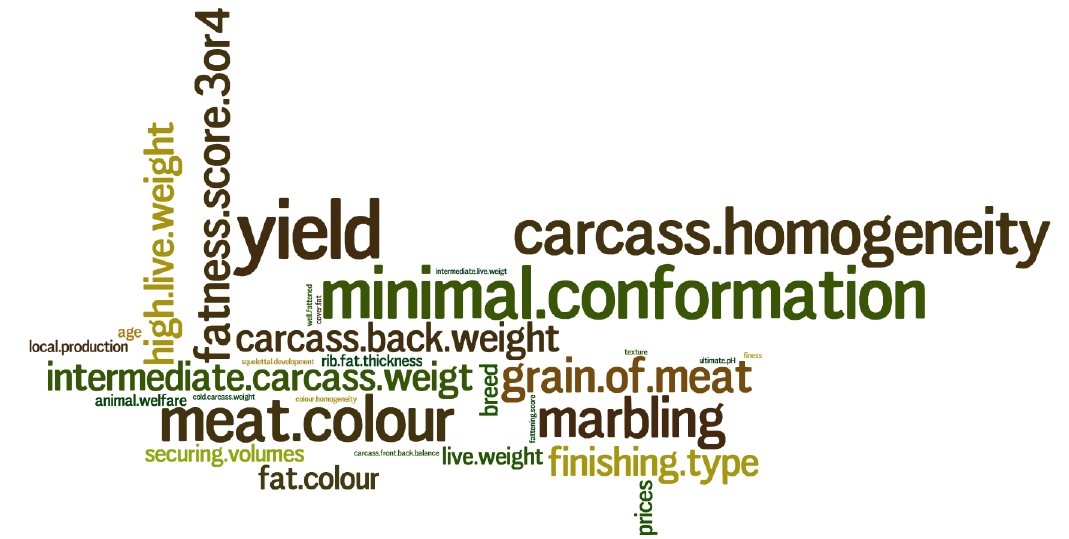
Figure 1. Main expectations expressed by the 13 operators in the sector surveyed. (The size of the expectations was proportional to its percentage of citation. For instance, yield was recorded in 83% of citations; minimal conformation 75%; carcass homogeneity and meat color: 67%; marbling: 58%; high live weight and fatness score 3 or 4: 50%; the other expectations were recorded in less than 50% of citations).